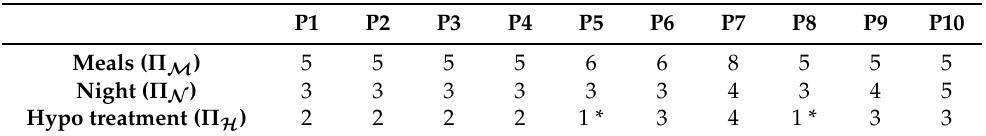
Table 1. Number of clusters considered for each patient (P) according to the FS cluster validity index. For patients 5 and 8, not enough hypoglycemia treatments were available to apply clustering (marked as *). In these cases, only a single local model is considered.